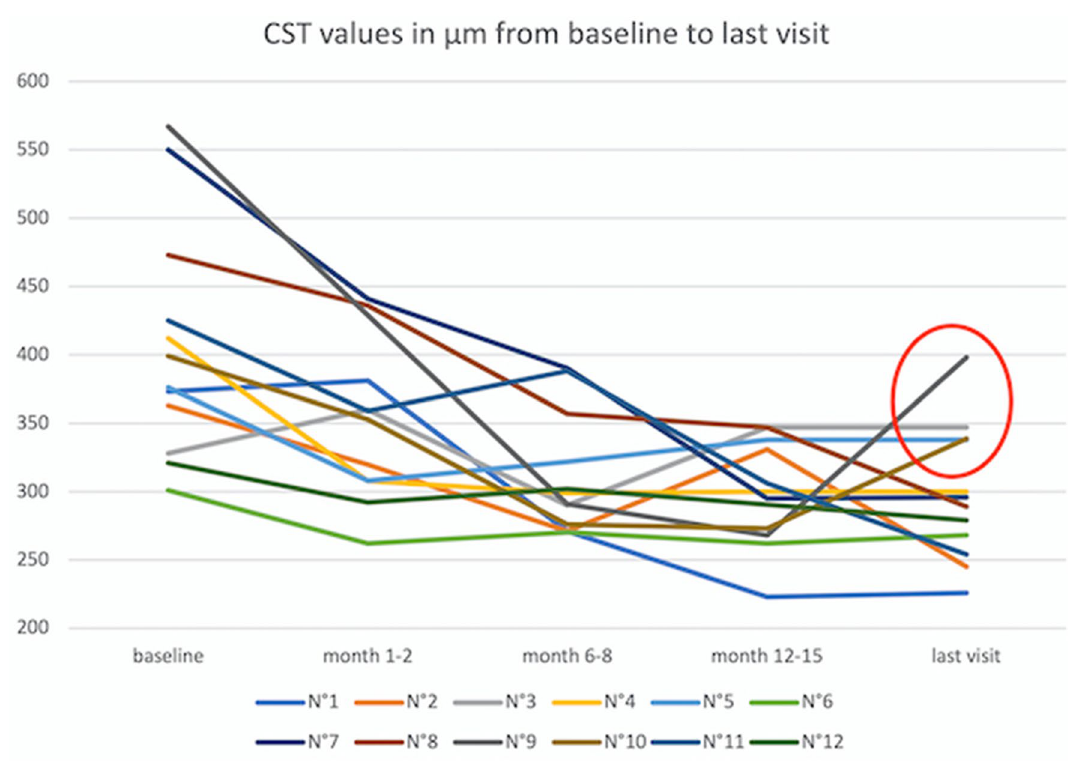
Figure 6. Morphological results of all eyes including the first visit after laser within the first 2 months. 8 eyes show CST-values below 300 µm throughout the follow-up period. Note that 4 eyes have CST values above 300 µm at the end of the follow-up (encircled in red). 2 of these 4 eyes (N°9 and N°10) had re-treatment with laser at their last visit during the follow-up period. One of the other 2 eyes showed progression of an epiretinal membrane, that was already present at baseline and presented with diffuse retinal swelling and no intraretinal cysts (N°3). The other eye showed stable visual acuity and an increase in CST of 30 µm from month 6 to 28 months after a good initial morphological response to laser therapy and was therefore not re-treated neither with focal laser nor with intravitreal